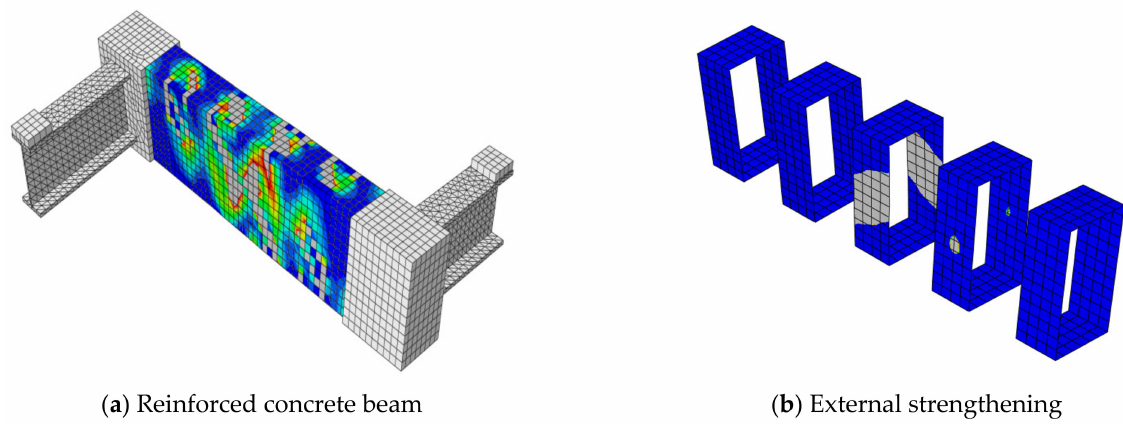
Figure 30. FE final cracks of beam B1-AS at the ultimate